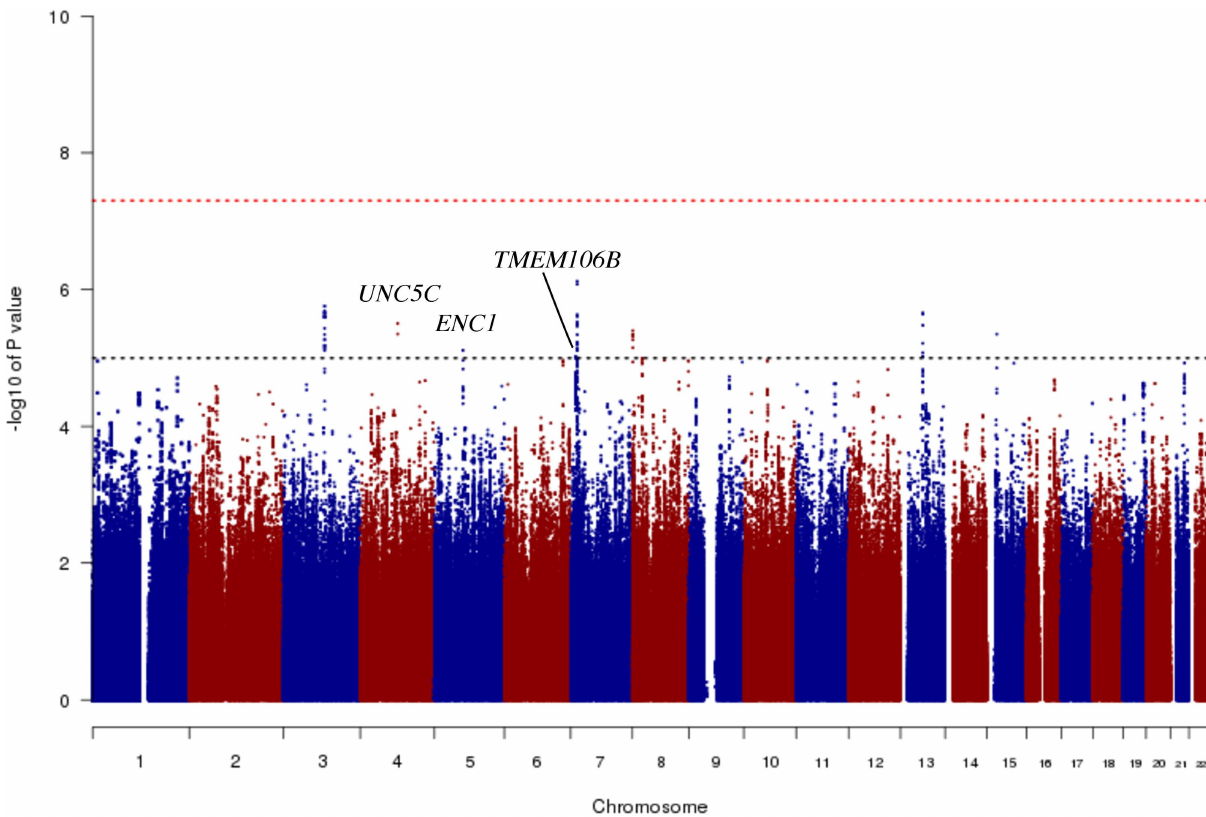
Fig 1. Manhattan plot from the genome-wide association study for residual cognition. In this plot, we present the results for each SNP tested in the genome-wide associationstudy that included979 participants from the ReligiousOrders Study and the Rush Memory and Aging Project. Each point is one SNP. The x -axis denotesthe physicalpositionof the SNP, and the y -axis reports − log( p- value) for each SNP. The threshold for a suggestiveassociation( p < 10 − 5 ) is denotedby the black dotted line and identifies those loci that were consideredin step 2 of our analysis. The red dotted line denotes the thresholdof genome-wide significance. The three loci considered in step 2 are highlighted: UNC5C , ENC1 , and TMEM106B .